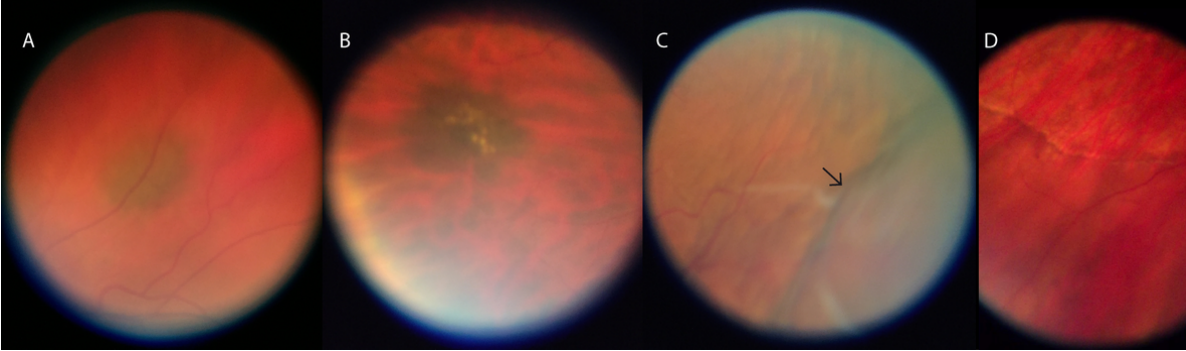
Figure 7. Exemplary smartphone-based fundus images from the mid periphery. (A) and (B) Choroidal nevi, (C) choroidal detachment (the out-of-focus area indicated by the black arrow), and (D) a subretinal demarcation line (high water mark) in a case of longstanding retinal detachment.